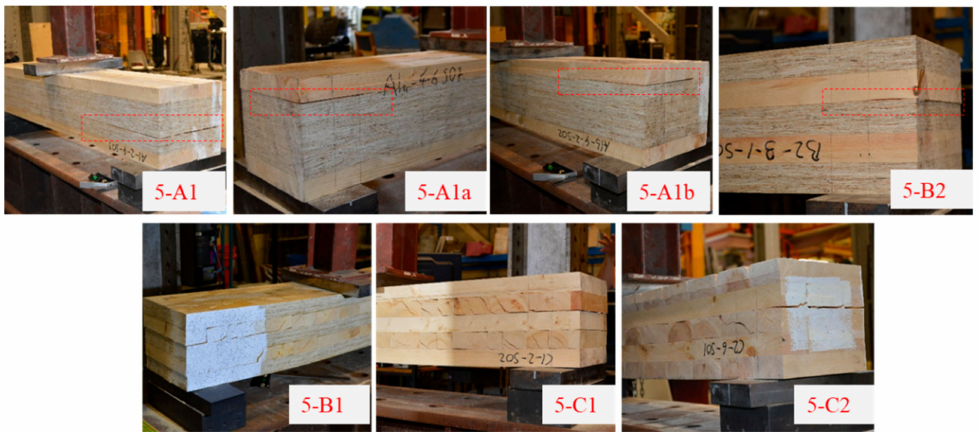
Figure 7. Typical failure modes under short-span bending (shear)